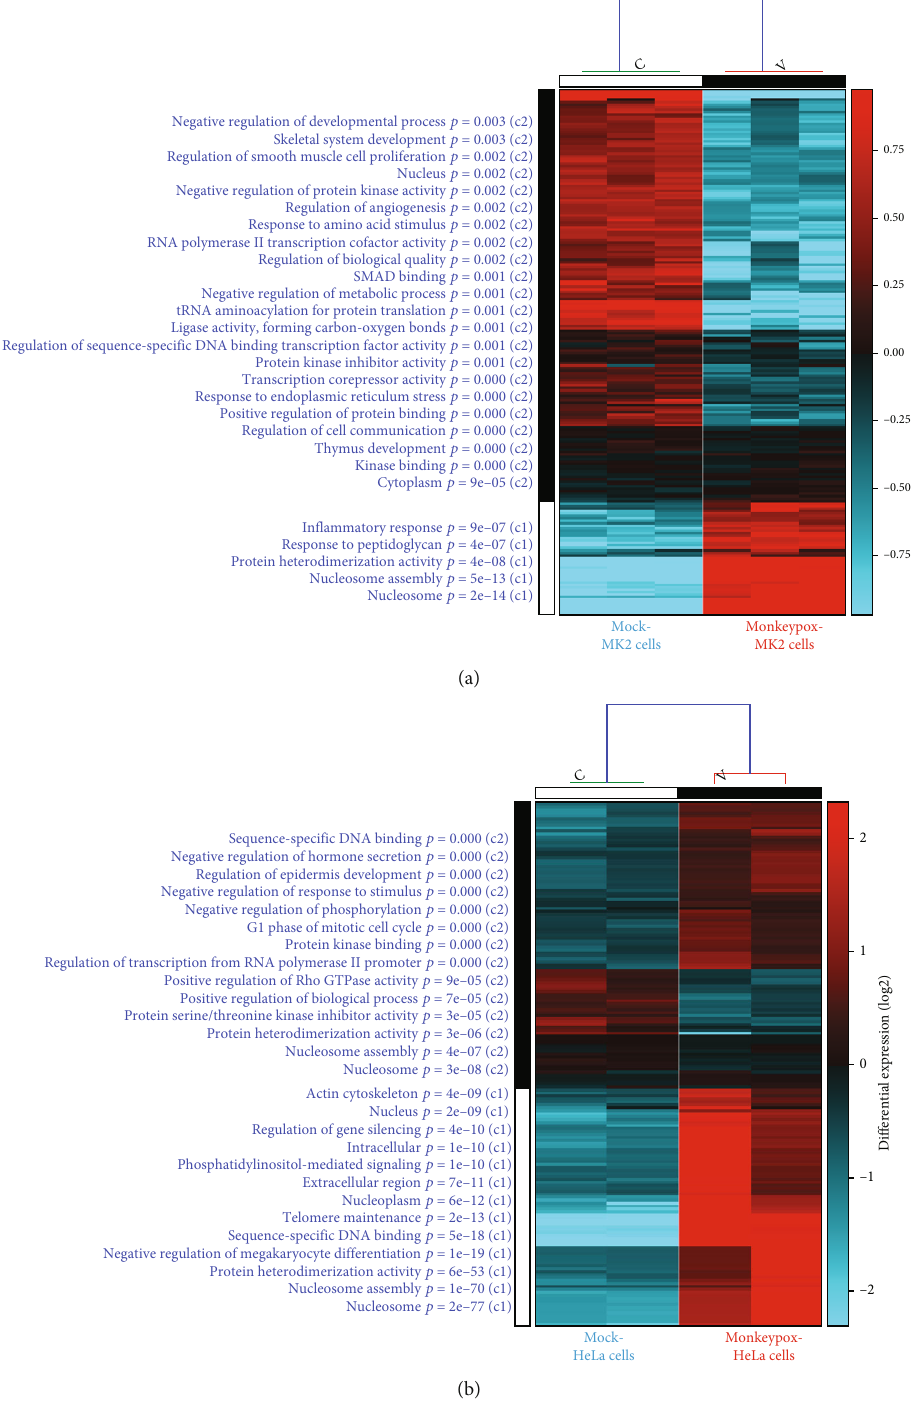
Figure 2: Analytical results of Gene Ontology (GO) enrichment accompanied by heatmap visualization in two separate monkeypox- infected models. (a) Comparison of gene expression patterns between the monkeypox-infected Macaca mulatta kidney epithelial (MK2) cells and the mock control. Cluster 1 (c1) contained the most signi fi cant highly expressed genes and pathways in the monkeypox- infected group, whereas c2 exerted an opposite trend. The GO analysis suggested that in fl ammatory and chemokine-related peptidoglycan pathways were signi fi cantly correlated with the monkeypox-infected Macaca mulatta kidney epithelial (MK2) cell model. (b) Comparison of gene expression patterns between the monkeypox-infected human immortal epithelial cancer (HeLa) cell model and the mock control. Cluster 1 (c1) contained the most signi fi cantly highly expressed genes and pathways in the monkeypox-infected group, whereas c2 exerted an opposite trend. The GO analysis suggested that nucleosome assembly and cytoskeleton-related pathways were found to be signi fi cantly correlated with the human immortal epithelial cancer (HeLa) cell